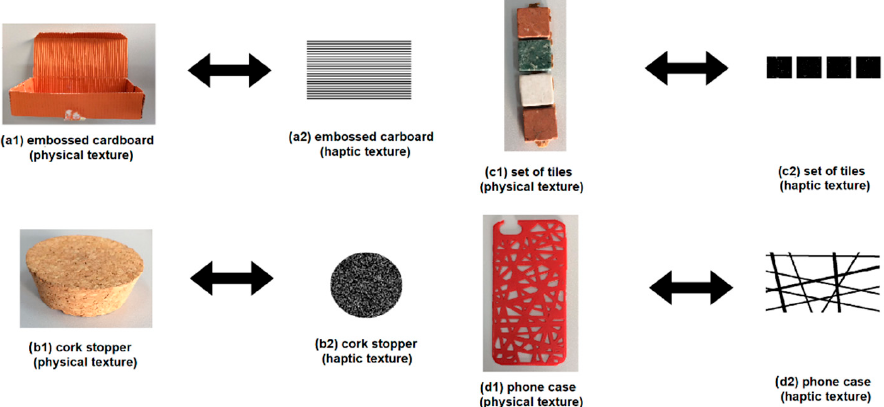
Figure 3. Correspondence between physical textures from real-world objects and haptic textures.